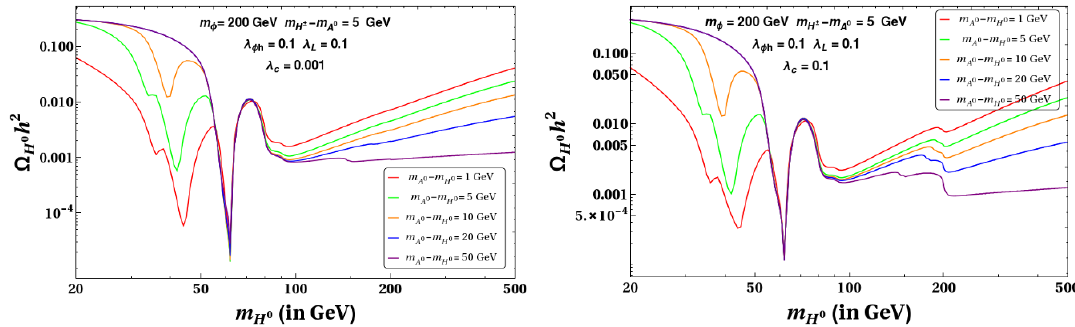
Figure 11 . (cid:10) h 2 vs m for (cid:21) c = 0 : 001 (left panel) and (cid:21) c = 0 : 1 (right panel) with di(cid:11)erent H 0 H 0 choices of m (cid:0) m which are depicted by di(cid:11)erent coloured lines in the (cid:12)gure. The A 0 H 0